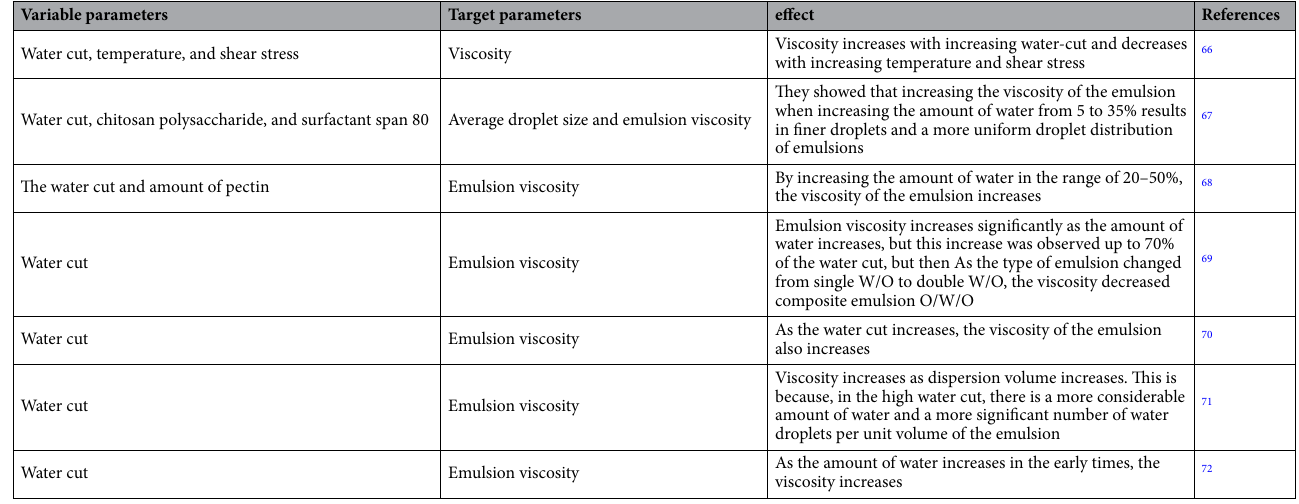
Table 4. Effect of water content on emulsion properties.